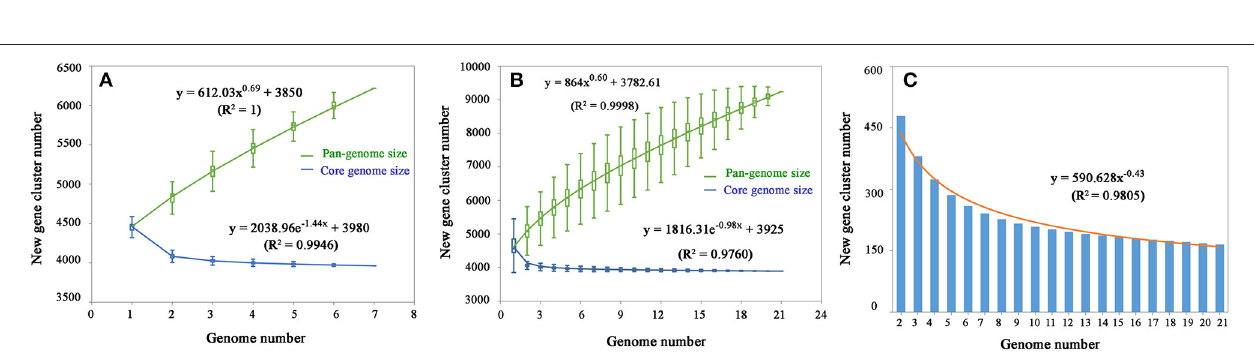
FIGURE 3 | The profiles of pan-genome and core genes of the seven strains (A) and 21 strains (B) of V. alginolyticus , and the profile of increased new genes in the 21 strains (C)